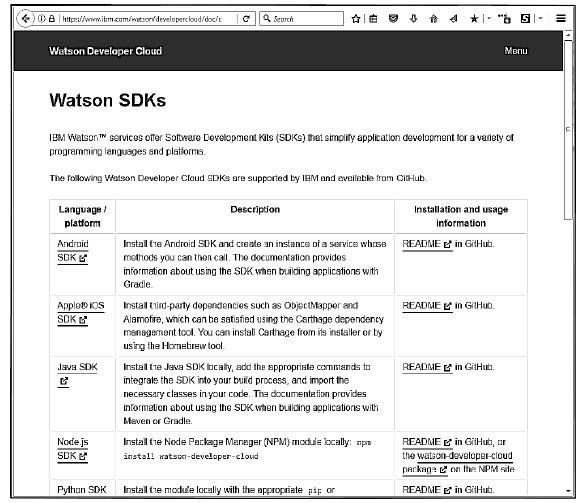
Fig. 19. IBM Bluemix provides separated SDKs for groups of offered services, such as for Watson